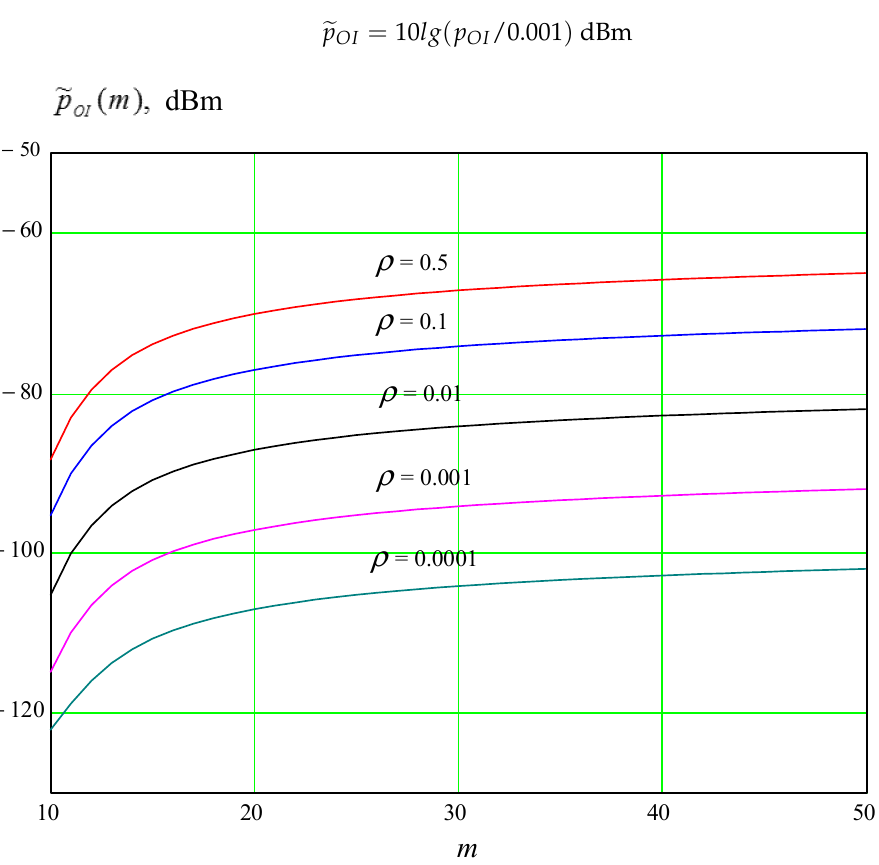
Figure 3. Dependence of the interference power level on the number of nodes (lattice nodes).